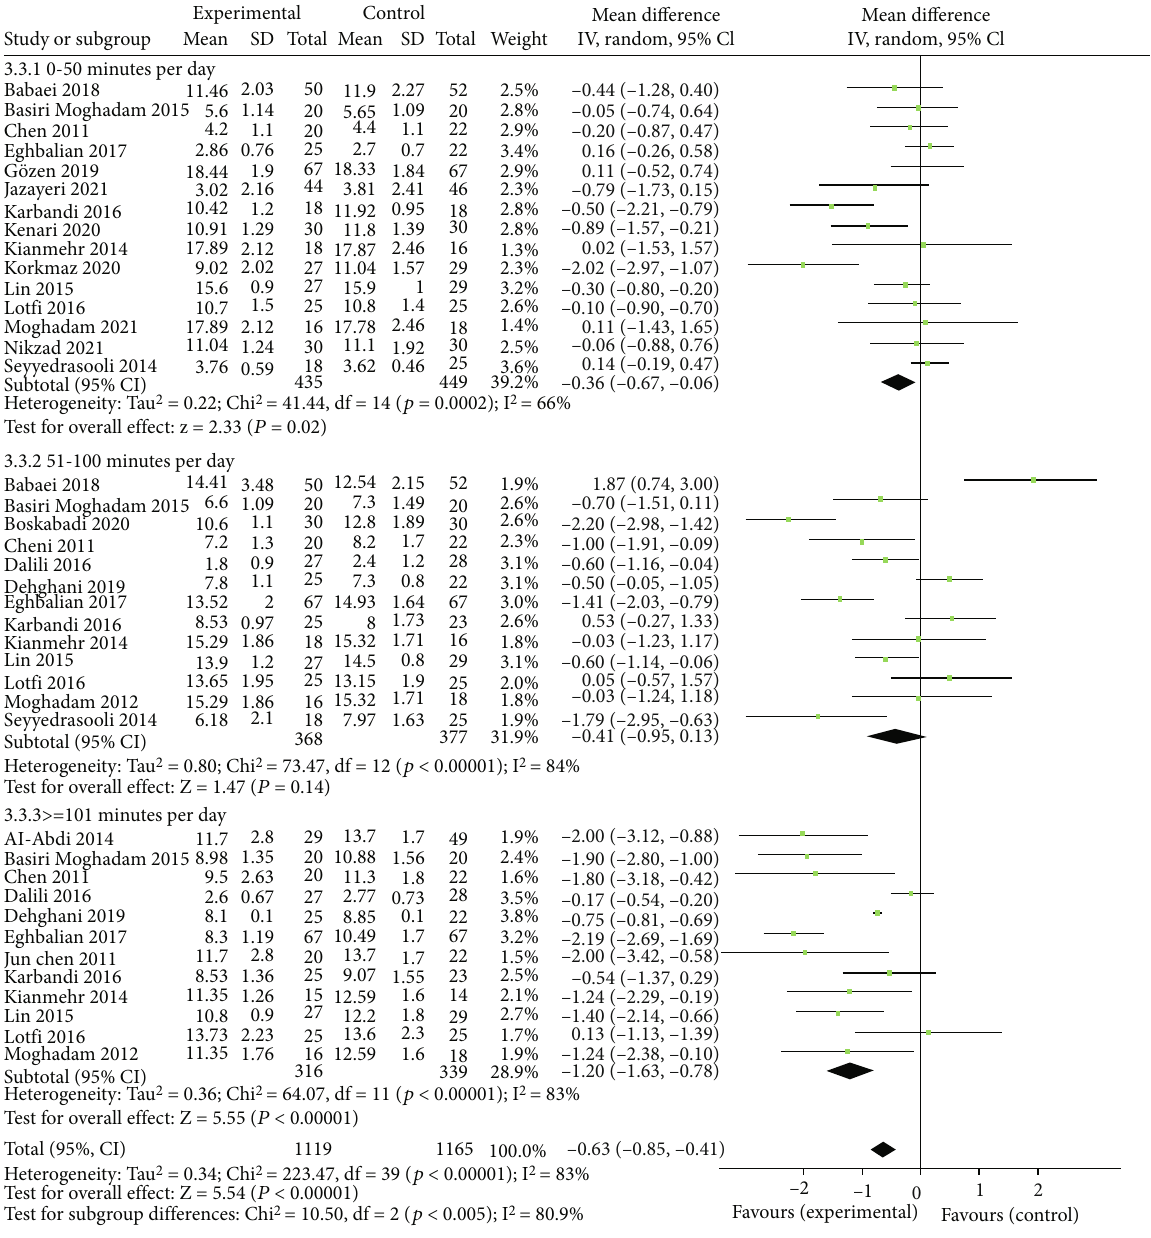
Heterogeneity: Tau 2 = 0.36; Chi 2 = 64.07, df = 11 ( p < 0.00001); I 2 = 83%